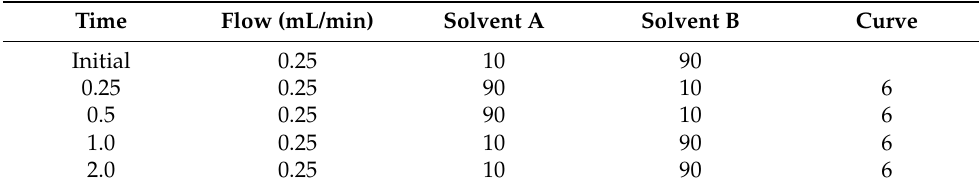
Table 1. Gradient condition of the mobile phase used for sample separation. Flow (mL/min) Solvent